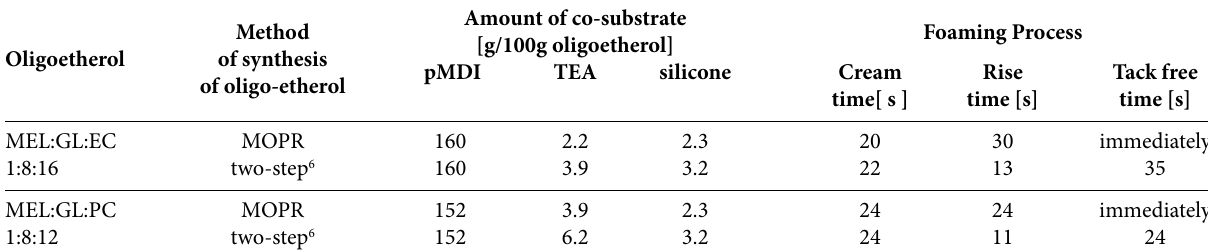
Table 4. Foaming process